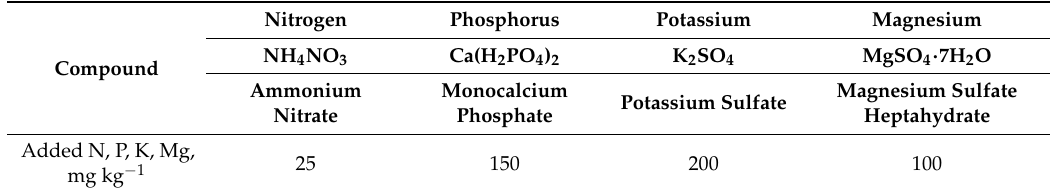
Table 3. Added basic fertilizer to 1 kg soil substrate.